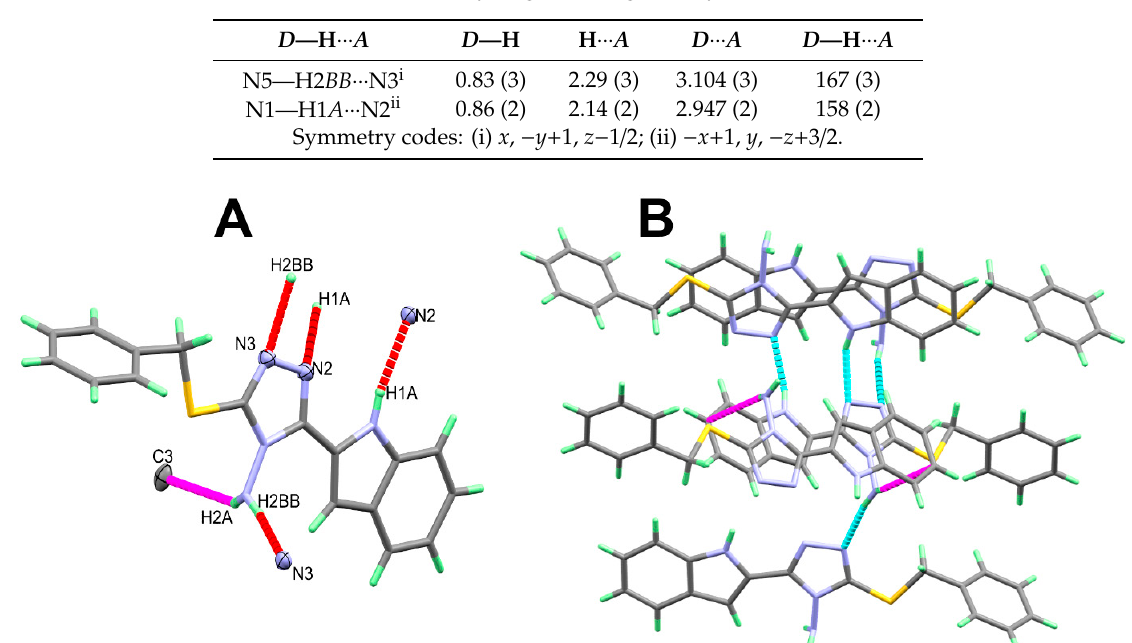
Figure 1. X-ray structure showing atom numbering and thermal ellipsoids at 30% probability level.